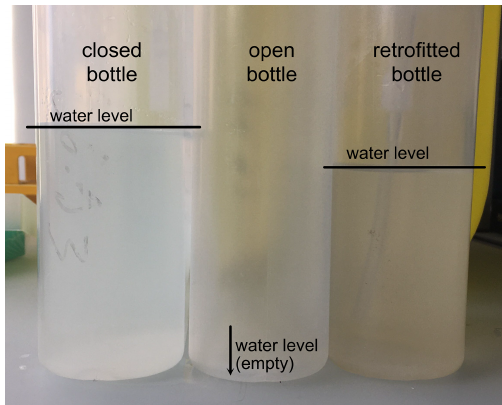
Figure 3. Water levels in the three bottles stored outside of the au- tosampler on day 24 of Experiment 1. The water level in the closed bottle is identical to the water level in all three bottles at the start of the experiment. By the end of the experiment the water level in the retrofitted bottle had only decreased slightly, while the water from the open bottle was completely evaporated after approximately